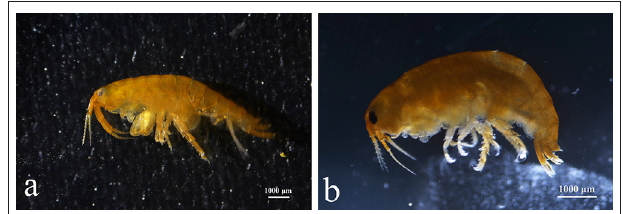
FIGURE 2 | Apohyale sp. from station R (a) and Q (b)